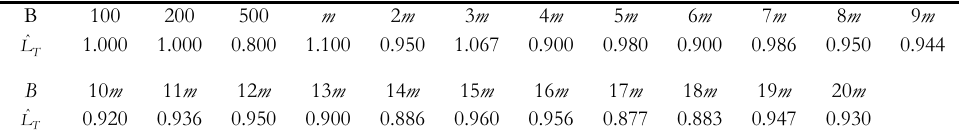
Second application: resulting estimated percent